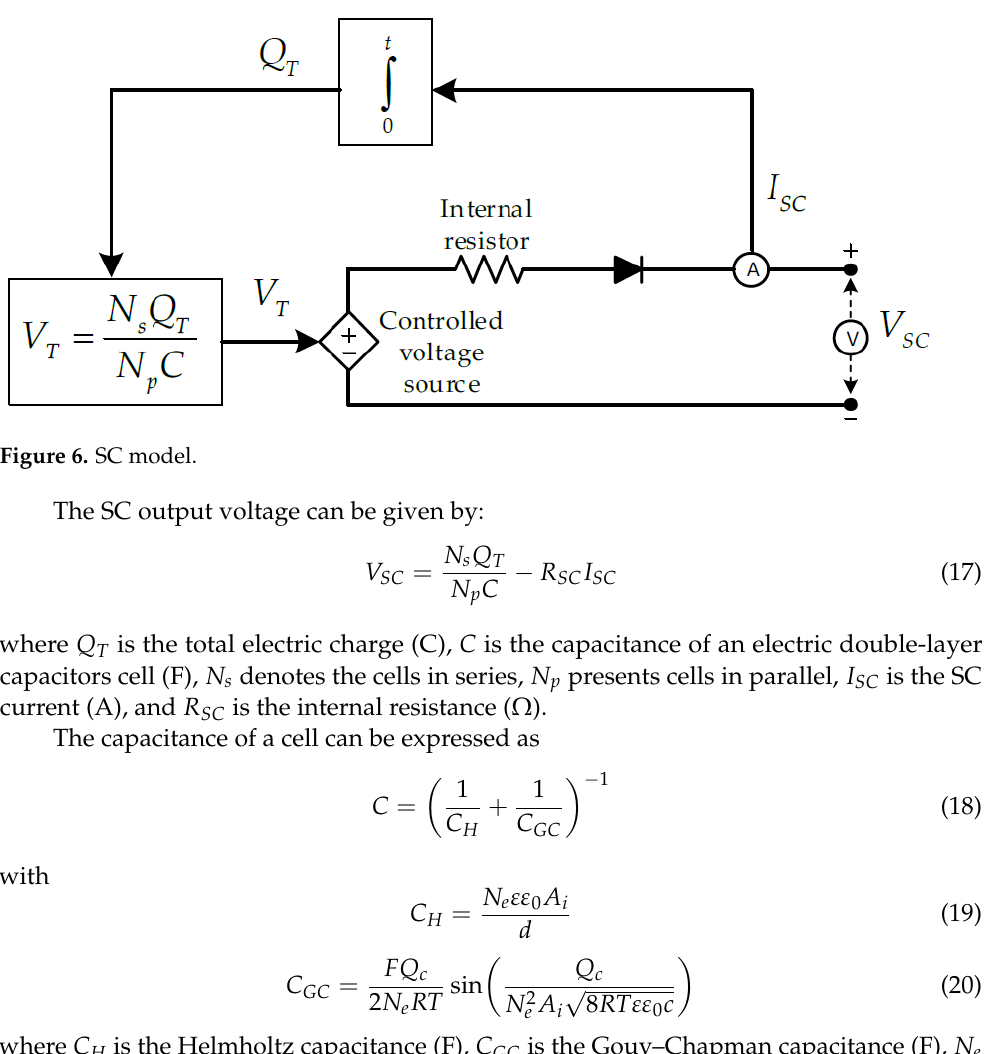
Figure 5. Polarization curves of the BAT. ( a ) Nominal current discharge characteristics. ( b ) Discharge current.